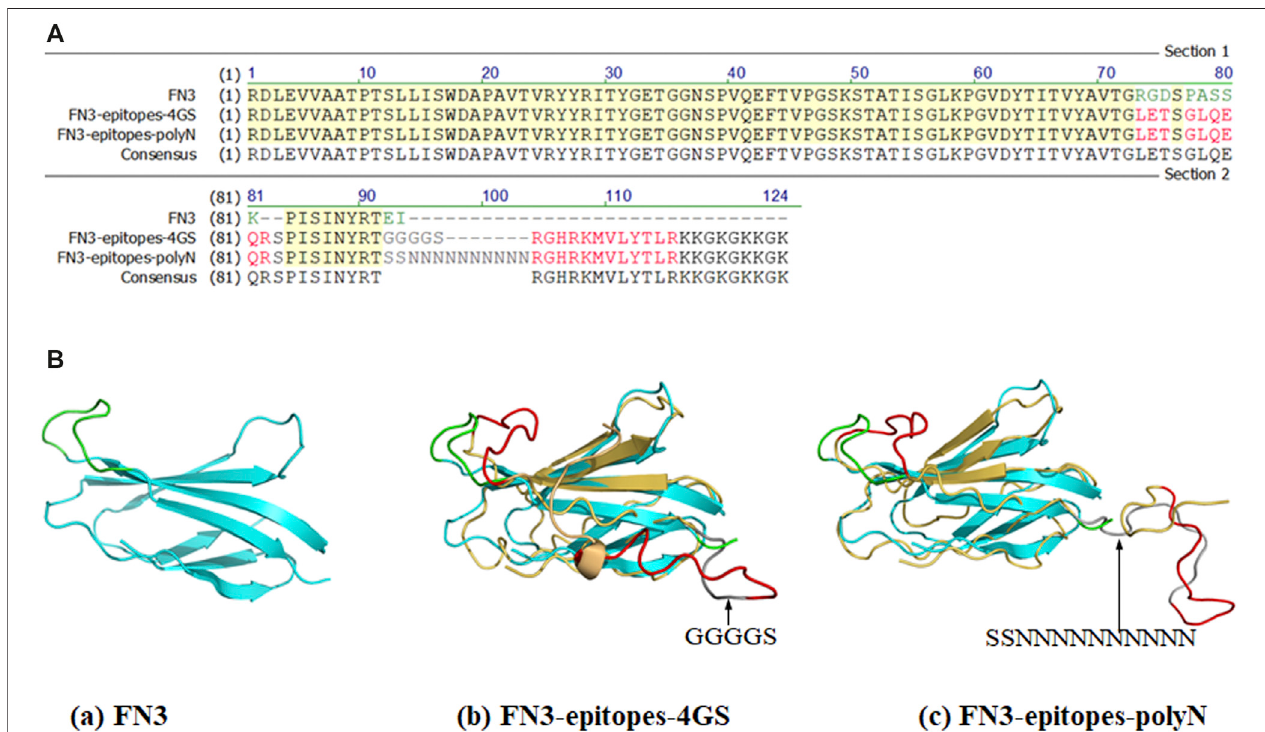
FIGURE1| PartialsequencesandstructuresofFN3,FN3-epitopes.( A )ThepartialsequencesofFN3proteinengineeredwiththeNT-proBNPepitopes.Thegreen lettersrepresentFGloop(RGDSPASSK)areasorC-terminus(EI)ofFN3,andtheredlettersrepresent theinsertedNT-proBNPepitope12 – 21(LETSGLQEQR) intheFG loop or epitope 62 – 73 (RGHRKMVLYTLR) in C-terminus. The grey letters represent the inserted 4 GS linker or polyN linker. ( B ) The 3D structures of FN3 (cyan) and modeling structures of recombinant FN3 with NT-proBNP epitope sequences (epitope 12 – 21 and epitope 62 – 73 were shown with red colored lines) at different sites, and the 4 GS linker or polyN linker was shown with dark grey coloring lines. The backbones of the FN3 are colored in cyan, which are superposed with the homology models in